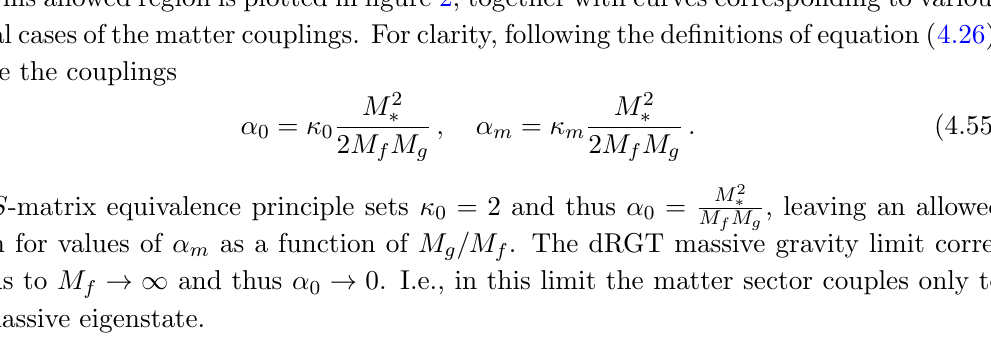
JHEP06(2018)075 2 and (cid:3) 2 M f M g